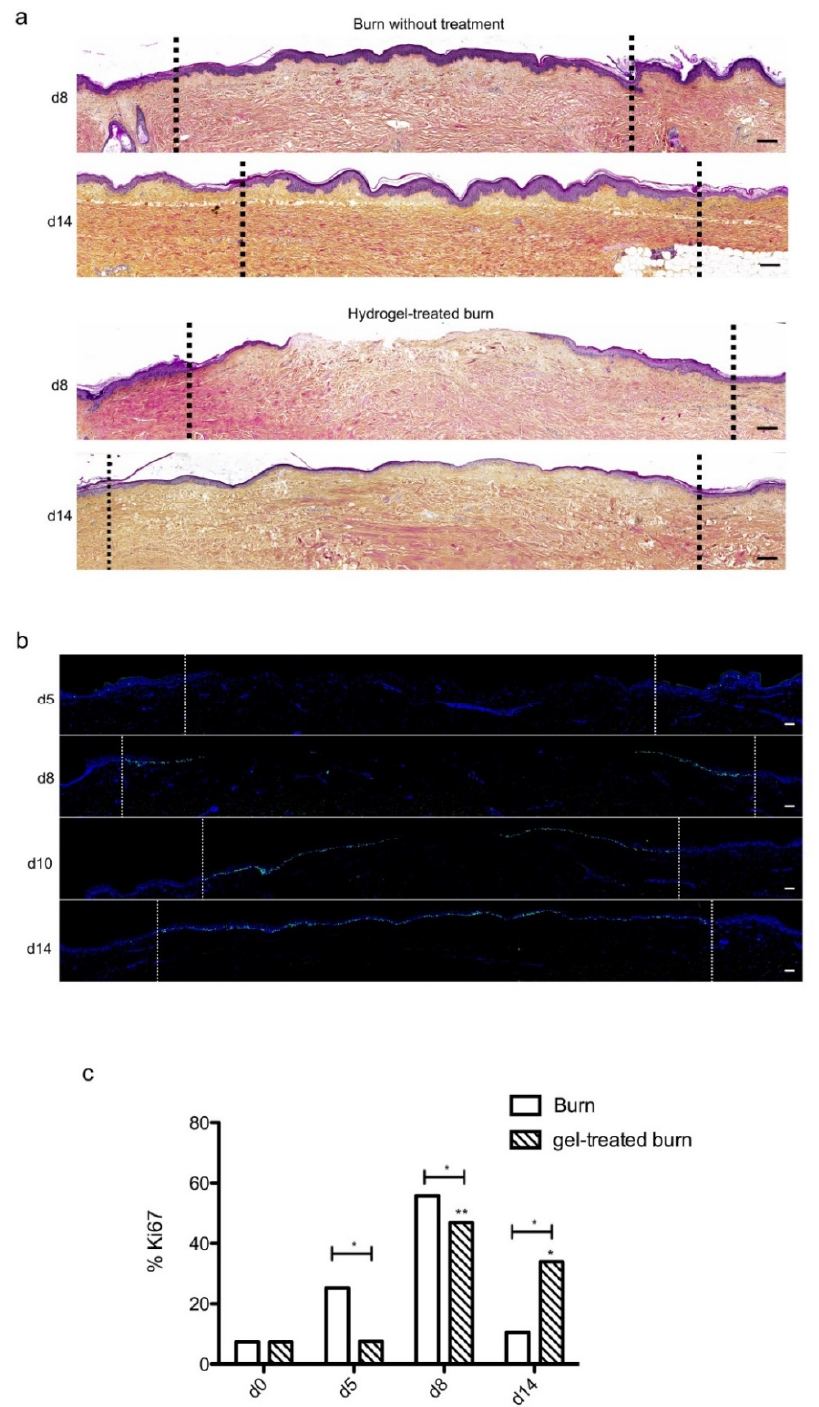
Figure 7. Kinetics of re-epithelialization in poloxamer hydrogel-treated ex vivo cultured human skin explants submitted to 10 s long experimental burn injury. A 10 s burn was carried out on ex vivo cultured human skin explants and, after wound debridement, on day 1, daily treatment with poloxamer p407/p188 hydrogel was applied. The impact of hydrogel applications on the healing process was assessed by ( a ) morphological analysis using HPS staining and ( b ) immunostaining of the proliferation marker Ki67. ( a , b ) On day 8 post burn, the hydrogel-treated lesion was not re-epithelialized, in contrast to the untreated lesion. The treated wound was re-epithelialized on day 14 but only 3–4 layers of keratinocytes were observed in the central burnt area, indicating that re- epithelialization was delayed by hydrogel treatment. ( c ) The keratinocyte proliferation index (ratio of Ki67 + proliferating cells relative to the total number of epidermal cells) was measured in human skin explants harvested at different time points of the culture. For each donor ( n = 3) and for each time